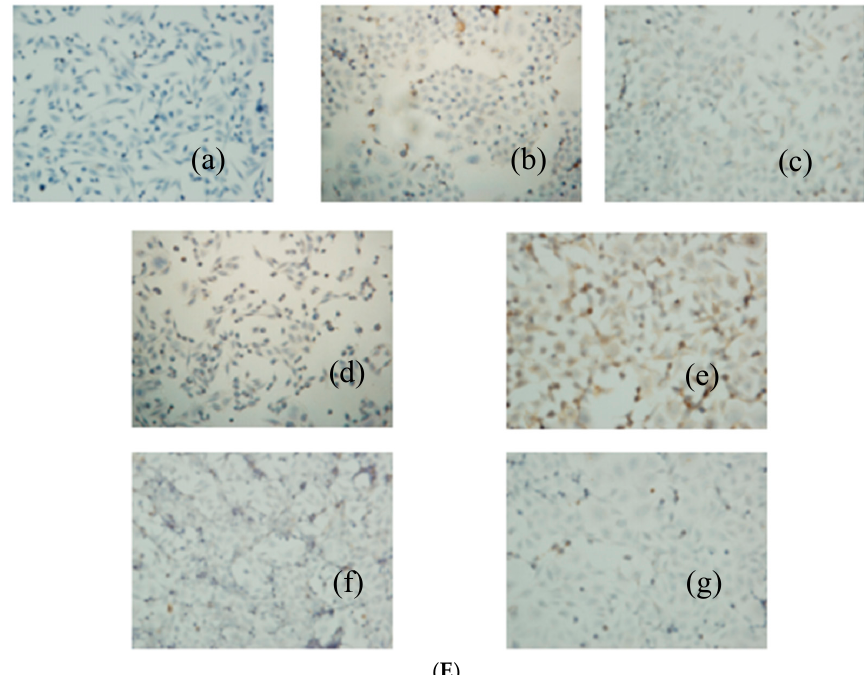
Figure 6. The Effects of PACC and PADF on the expression of multidrug resistance-associated proteins (×400). ( A ) Expression of P-gp; ( B ) expression of MRP; ( C ) expression of LRP; ( D ) expression of GST- π ; ( E ) expression of PKC. (a) blank control group, (b) BEL-7402 cells, (c) BEL-7402/5-FU cells, and (d) BEL-7402/5-FU cells were treated with 50 μ g/mL PACC; (e) BEL-7402/5-FU cells were treated with 85 μ g/mL PACC; (f) BEL-7402/5-FU cells were treated with 23 μ g/mL PADF; (g) BEL-7402/5-FU cells were treated with 45 μ g/mL PADF.